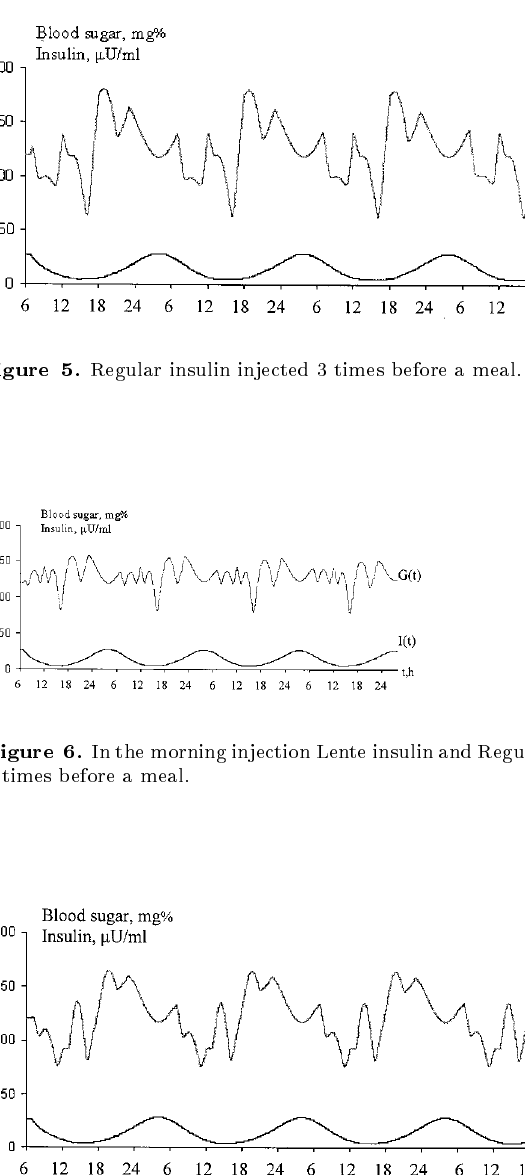
Figure(cid:7)(cid:1)BeforeabreakfastLente(cid:9)SemilenteandRegularinsulin(cid:9)before